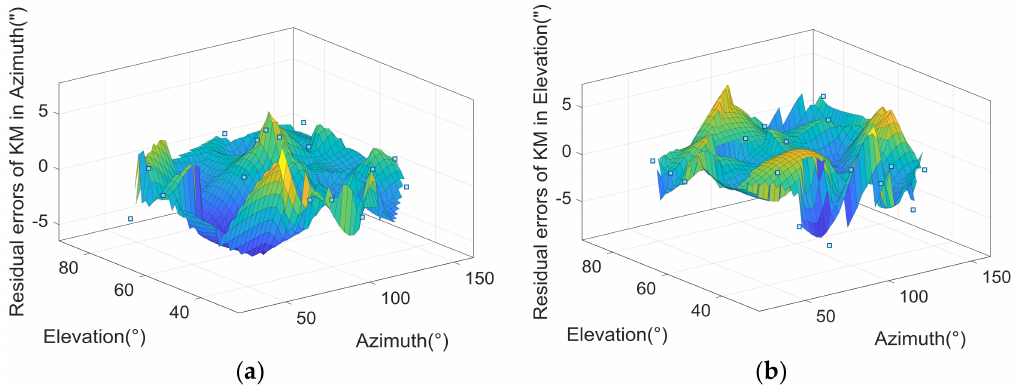
Figure 5. Residual errors and fitting surface of mount model: ( a ) in azimuth; and ( b ) in elevation. Table 1. Pointing precision of the alt-az telescope after calibration.